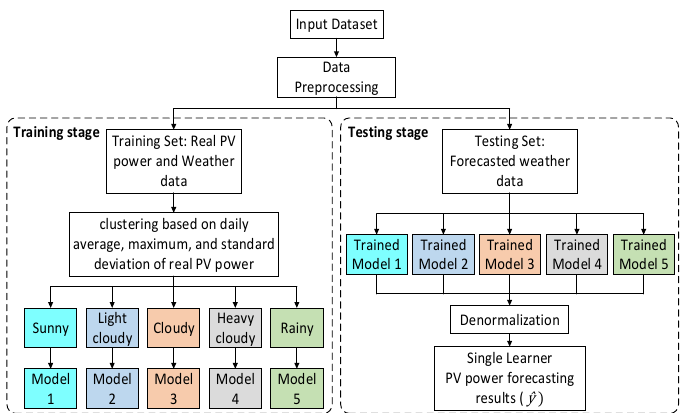
Figure 4. Flowchart for training and testing stages of each single model.